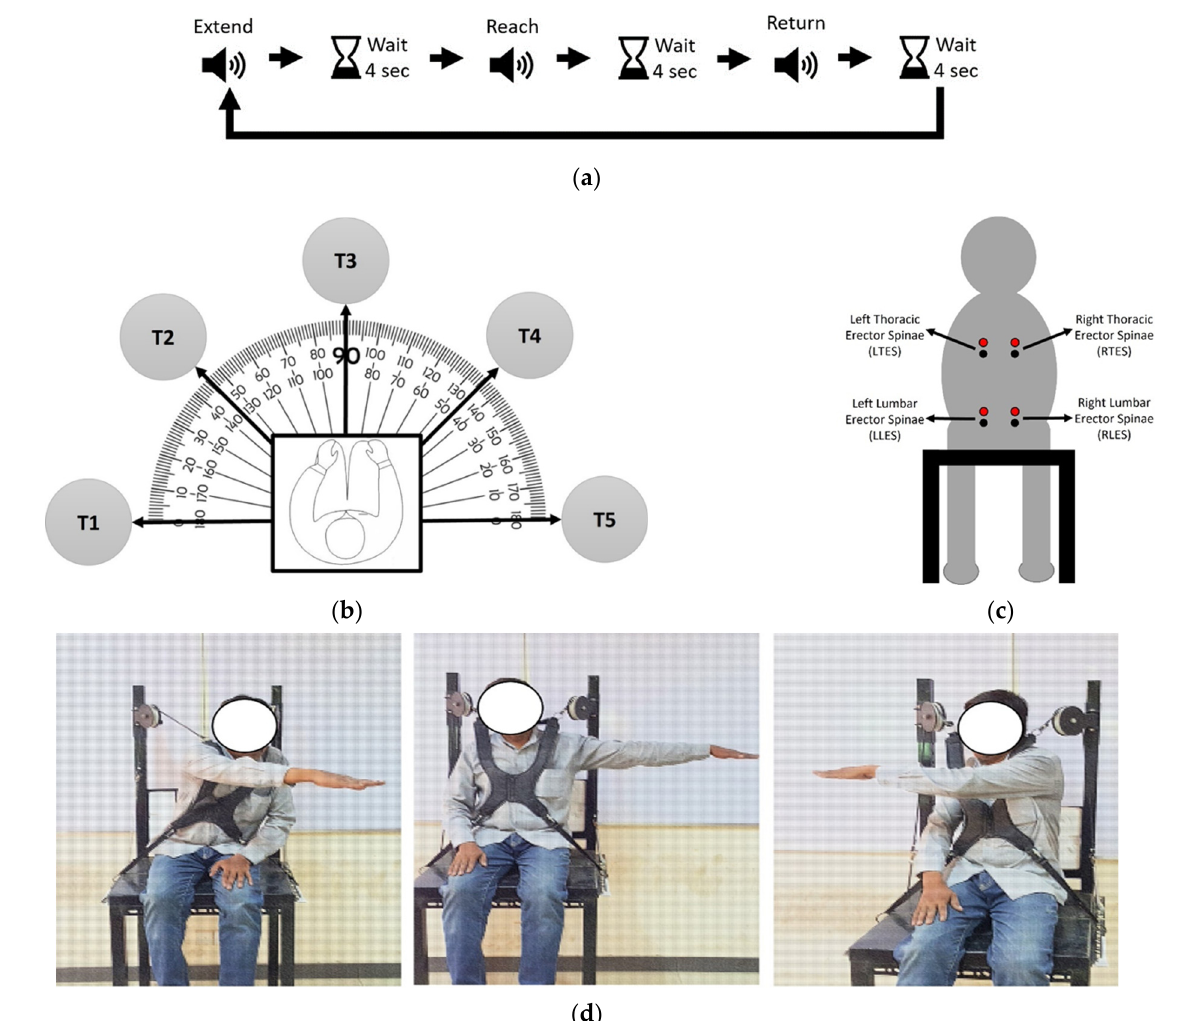
Figure 2. Experimental procedure. ( a ) The sequence of events in each task. The task started with the audio instruction of extending arm towards target (Extend), followed by a pause of 4 s, then audio instruction of reaching for the target (Reach), followed by a pause of 4 s, then audio instruction of returning to neutral position (Return), followed by a pause of 4 s. Audio instructions for the next task are then generated in the same manner. ( b ) The location of targets with respect to the seated participant (top view). Five targets, named T1, T2, T3, T4, and T5, are placed relative to the chair at precisely measured (from left side) angles of 0°, 45°, 90°, 135°, and 180°, respectively. All targets are placed at a sufficient distance from the chair to avoid obstruction during the task. ( c ) The bipolar, positive (red), and negative (black) electrode placement for each muscle of interest on the seated participant (rear view). ( d ) Examples of static posture maintained by participant with orthosis when oriented towards targets (mentioned in parenthesis). Left: Reach with right limb at 135° (T2); Center: Extend with left limb at 0° (T1); Right: Reach with left limb at 180° (T5).